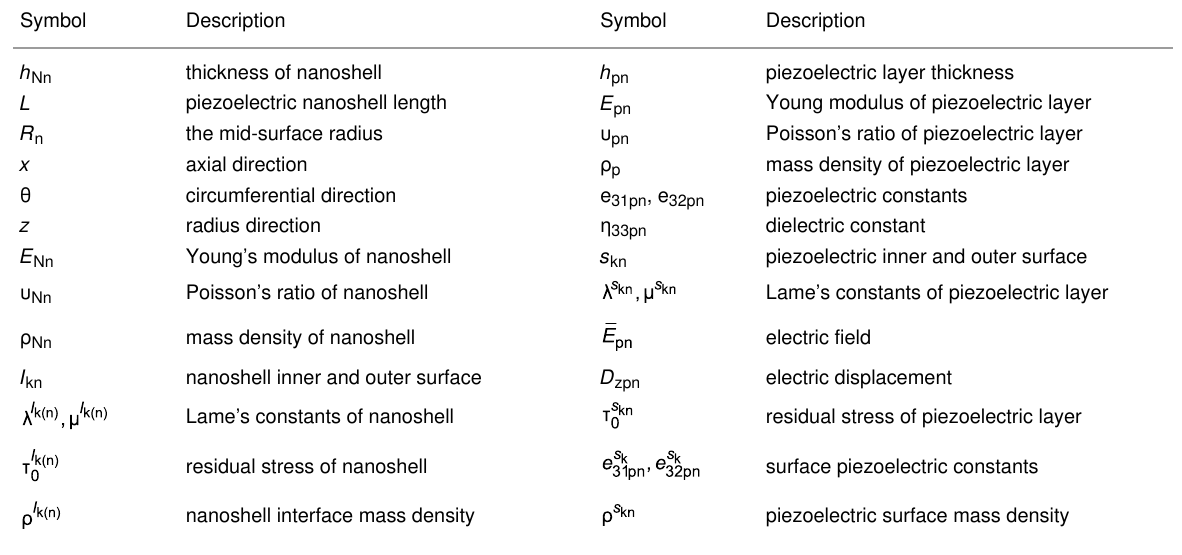
Table 1: Notation and symbols used in this work. Symbol Description